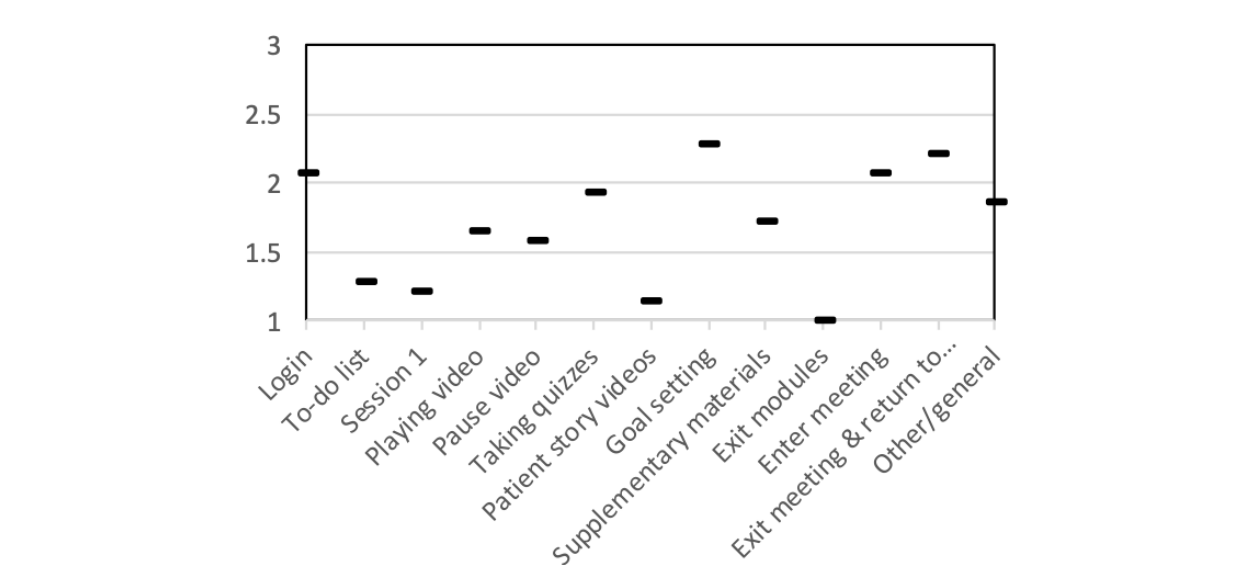
Patients tested the first session of the intervention. They had little difficulty with this activity (difficulty score: